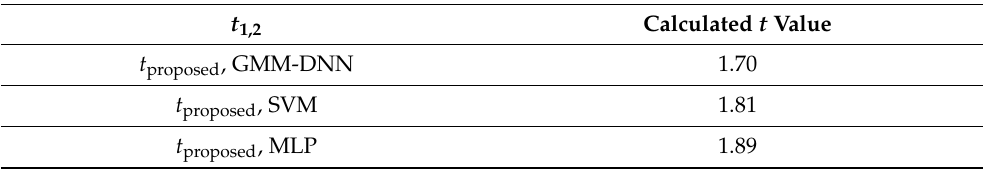
Table 1. Computed t values of the presented transfer learning method and GMM-DNN, SVMs and MLP using